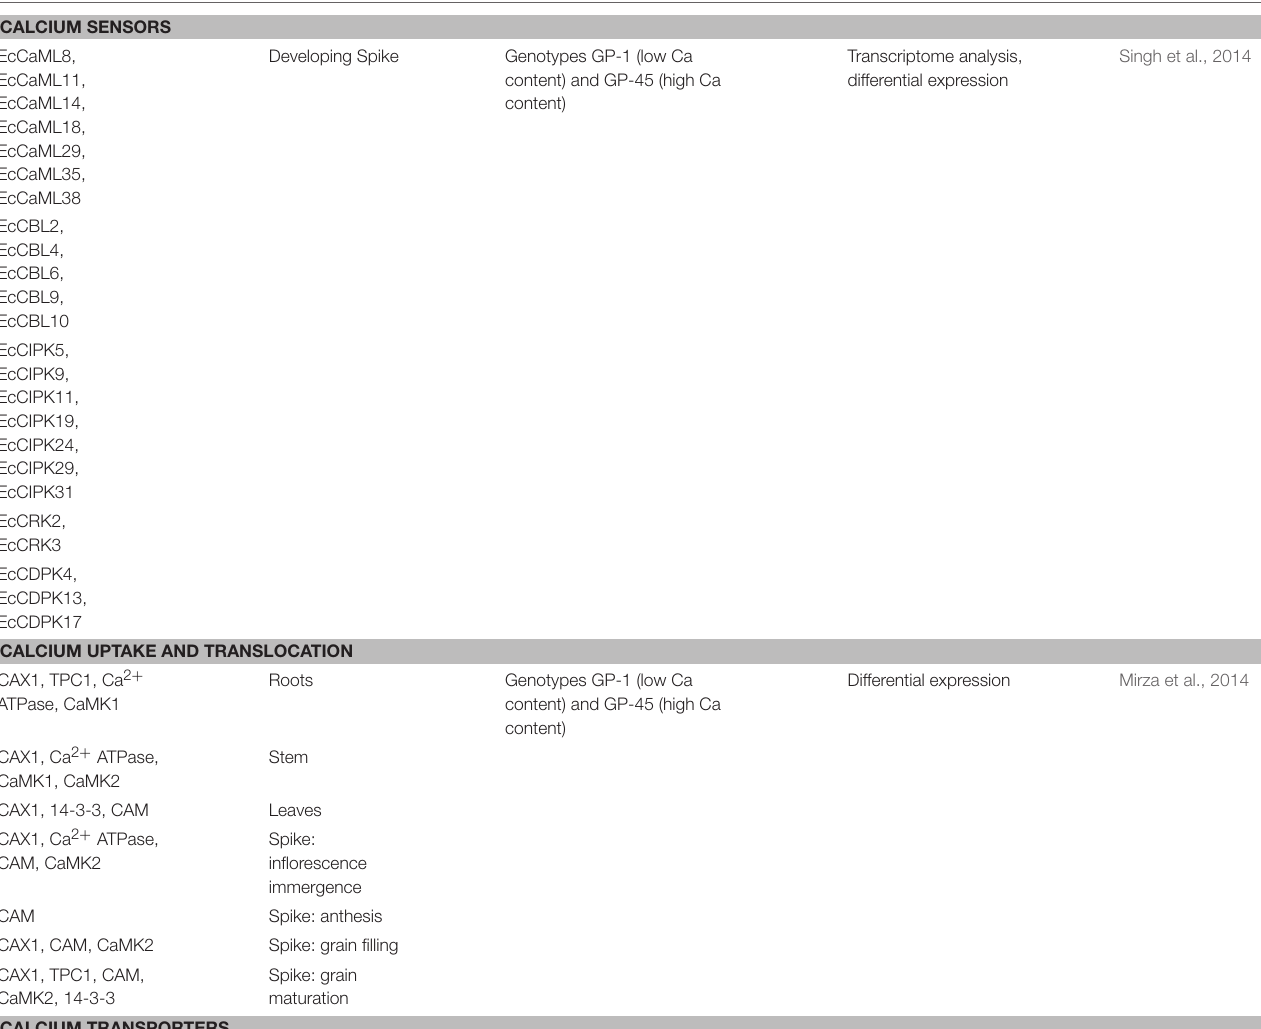
TABLE 3 | List of important genes identified for calcium uptake, transport and storage in finger millet. Gene/Transcript